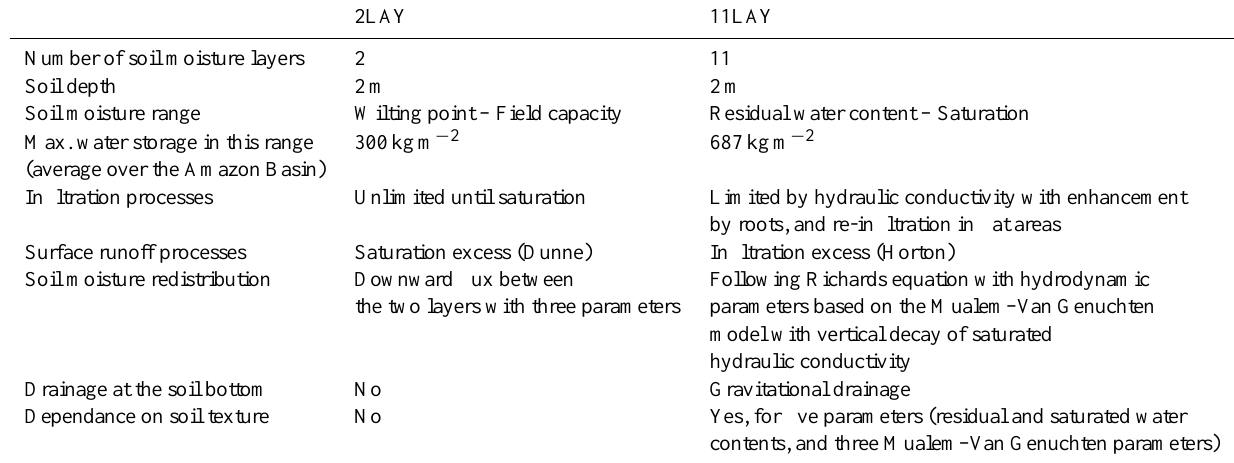
Table 1. Main differences and similarities between the two soil hydrology schemes, the 2LAY and